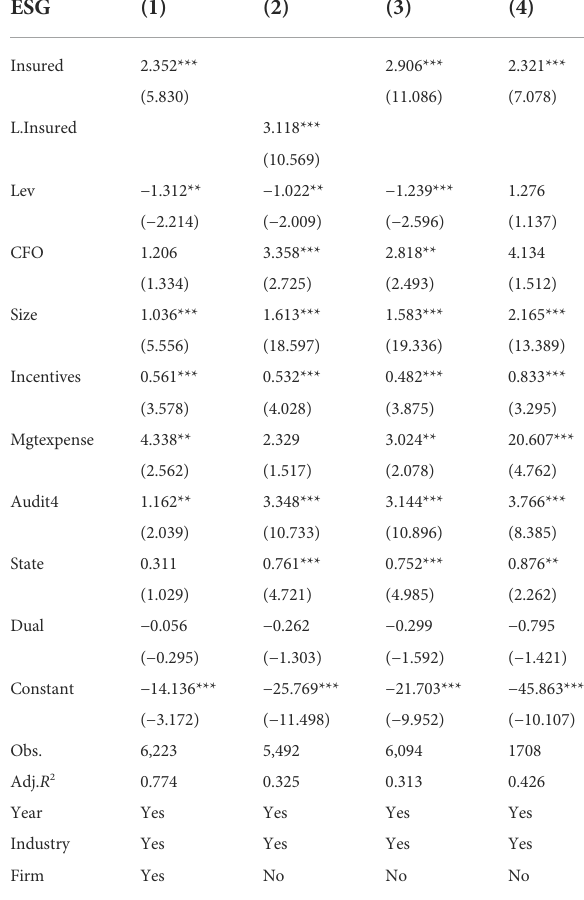
TABLE 5 Other robustness